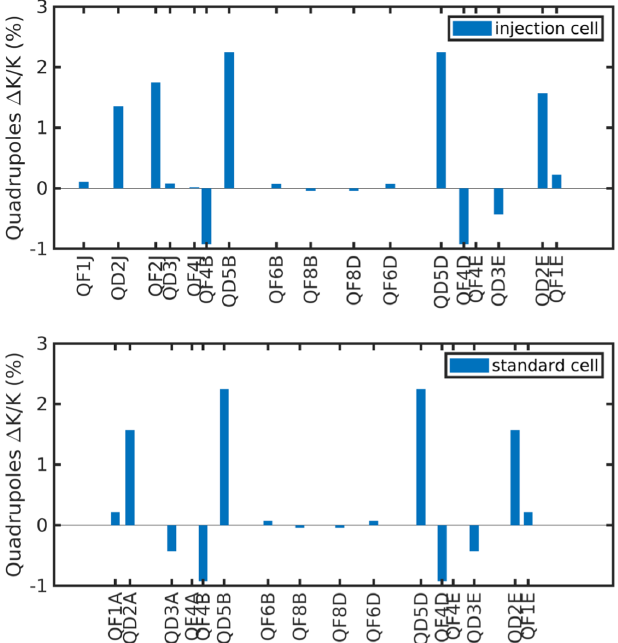
FIG. 13. Gradient corrections required to restore the design linear